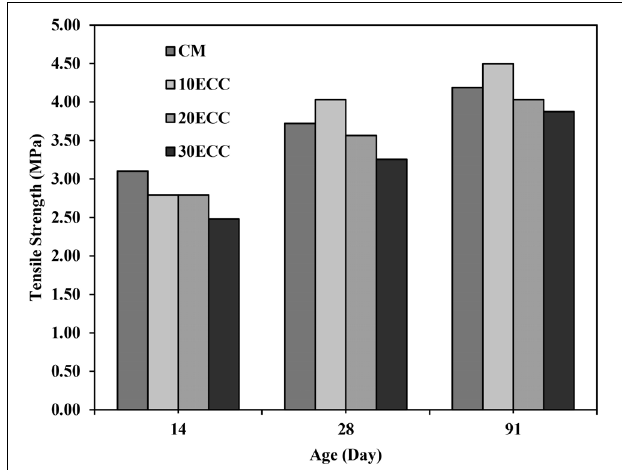
FIGURE 8 | Comparison of the load vs. strain relationship between CM and ECC mixes at an age of: (A) 14, (B) 28, and (C) 91